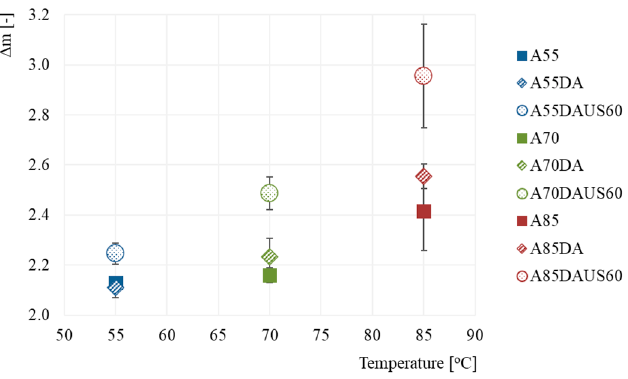
Figure 5. Relative mass gain ( ∆ m) of the dried apples obtained by the convective method with non-dehumidified air, dehumidified air, and dehumidified air with ultrasound pretreatment.